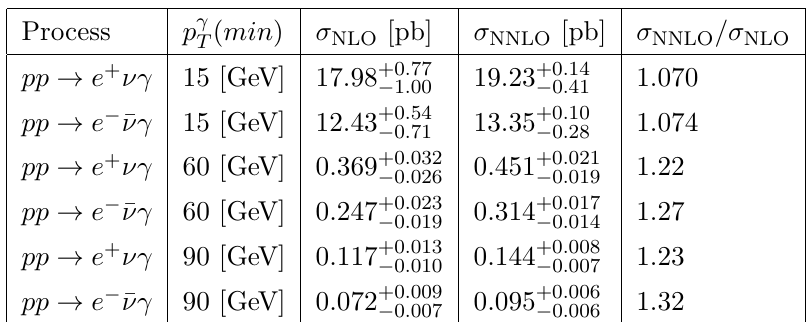
√ s = 7 TeV. The ratio σ NNLO /σ NLO is ( min ) . T